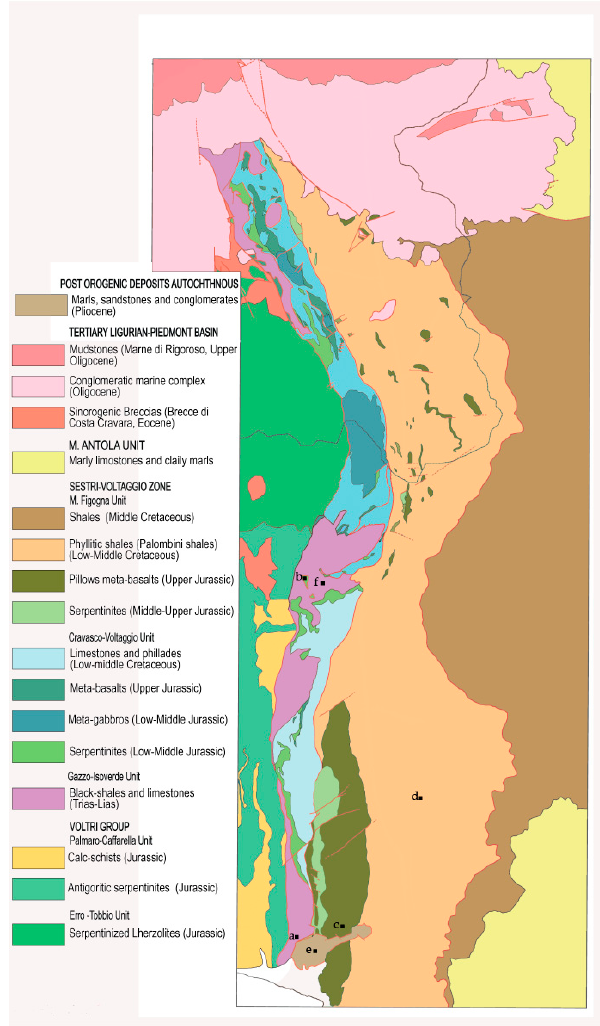
Figure 2. Geological sketch map of the Sestri–Voltaggio Zone and sampling area, respectively: ( a ) meta-argillites, ( b ) serpentinite, ( c ) metabasalts, ( d ) calc-schists, ( e ) debris, and ( f ) soil.